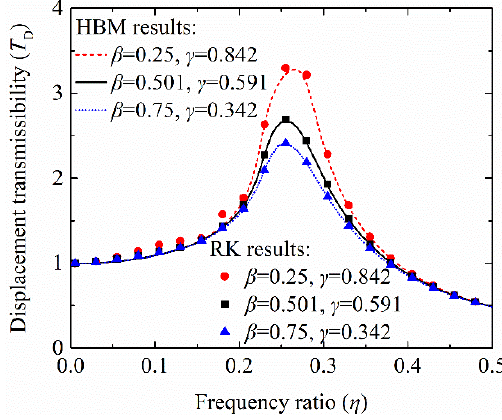
Figure 7. The frequency responses with A b = 1 mm and different values of β / γ . Table 2. The lowest peak transmissibility/resonant frequency and the corresponding excitation amplitudes with different values of β / γ . T pmin A b-pmin η rmin